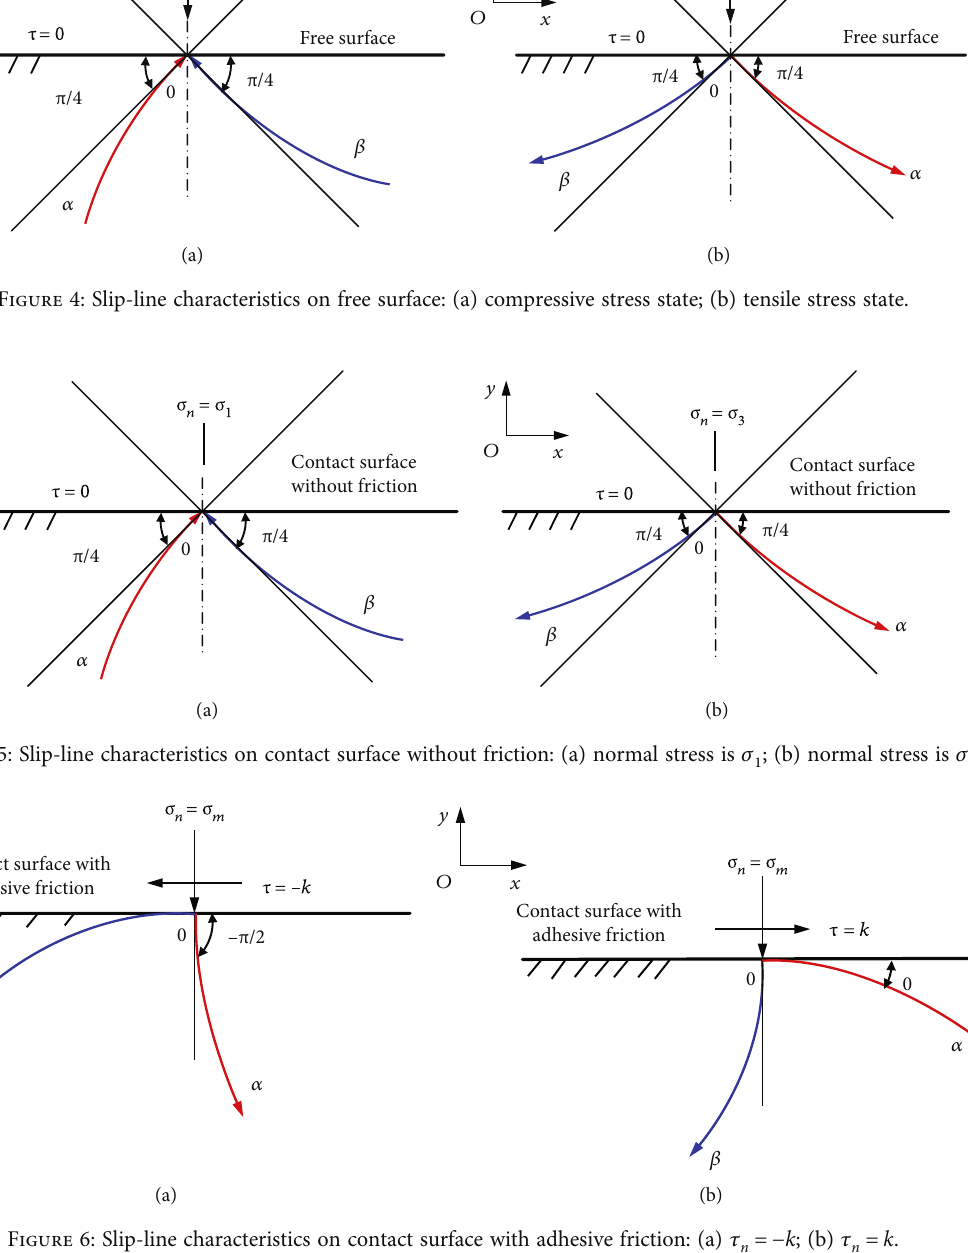
Figure 6: Slip-line characteristics on contact surface with adhesive friction: (a) τ